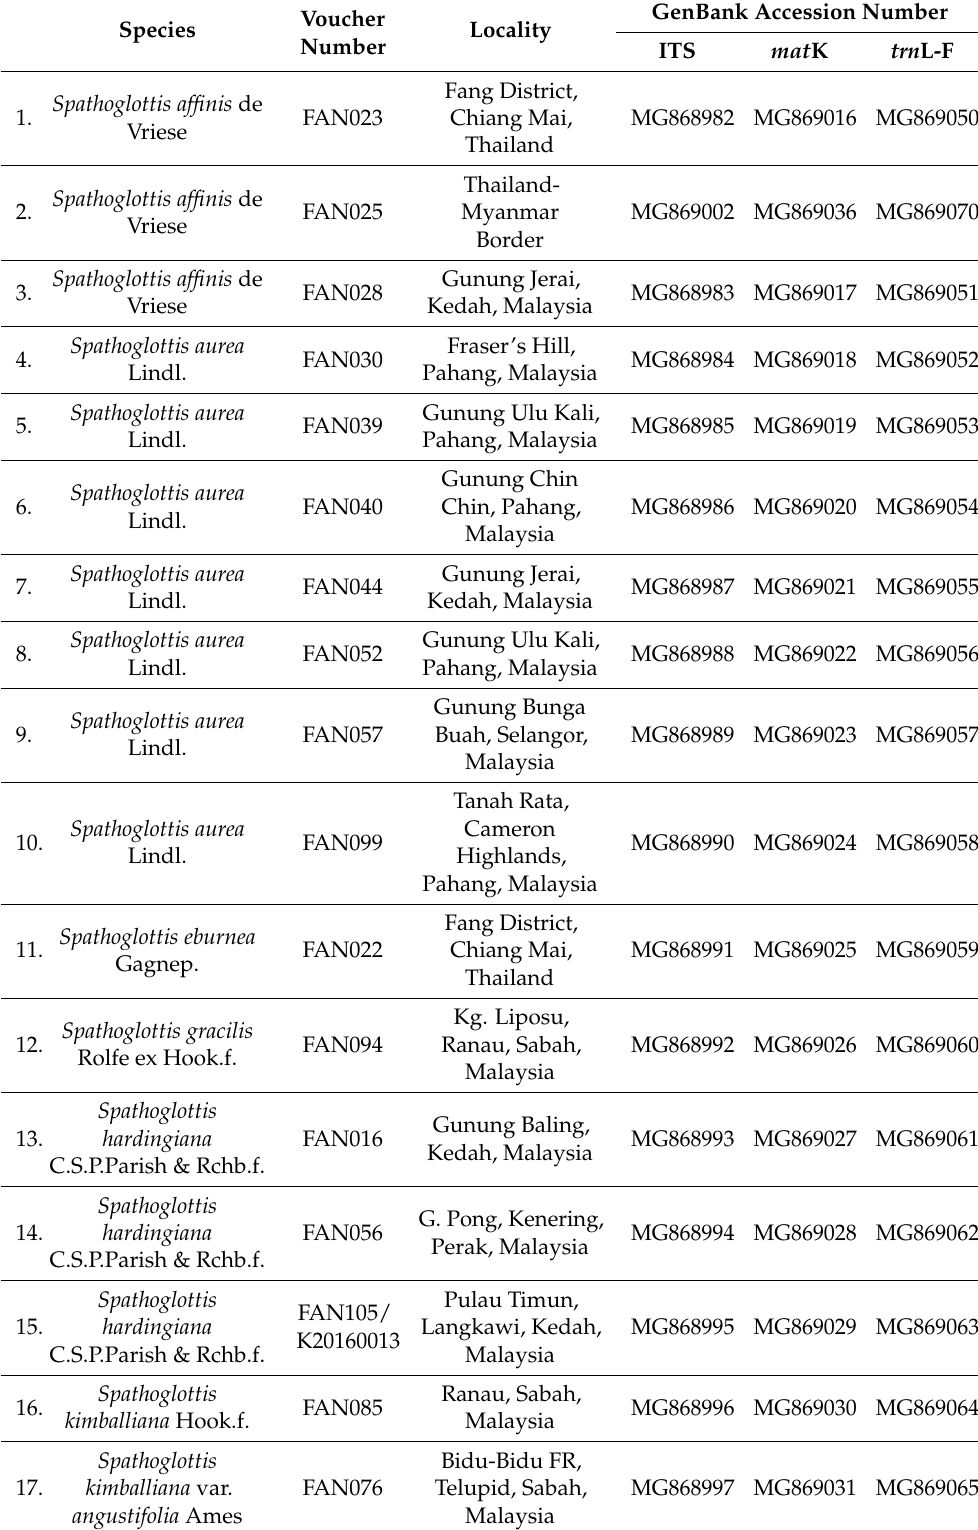
Table 1. Species list, herbarium voucher numbers, localities and GenBank accession numbers of the Spathoglottis species and outgroups used in this present